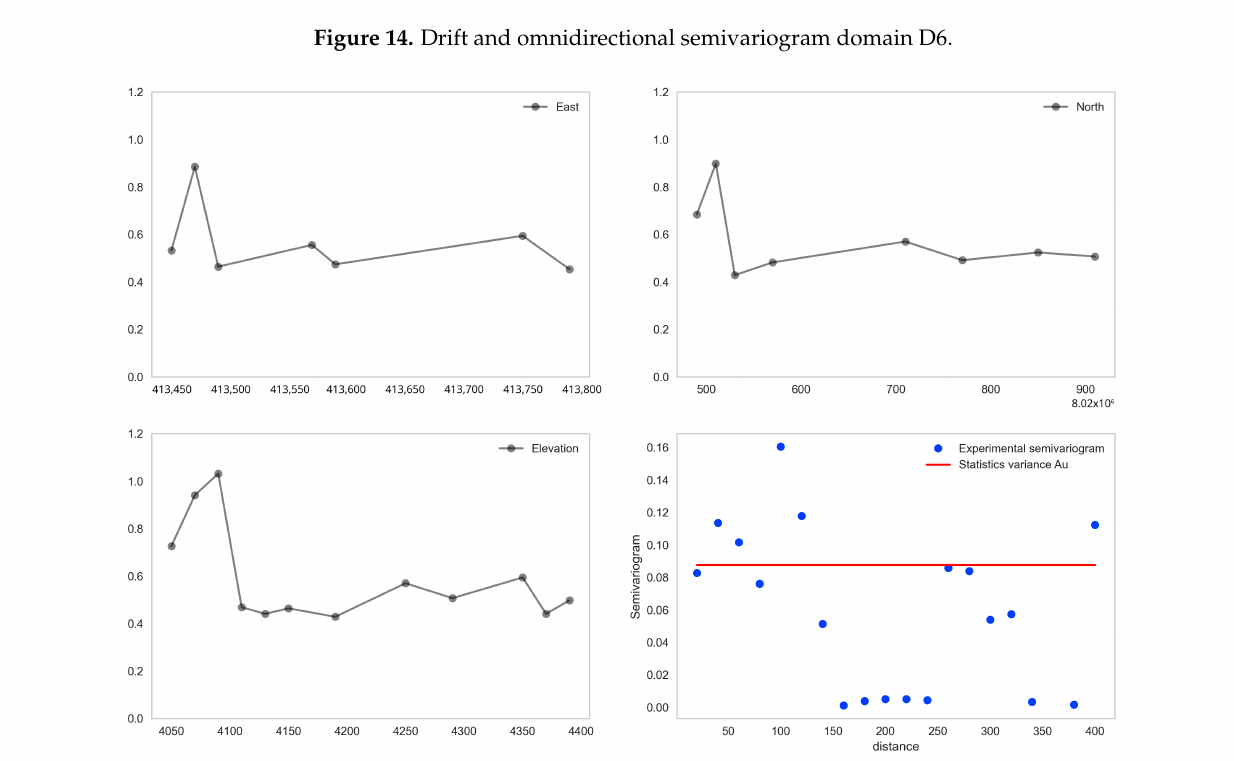
Figure 15. Drift and omnidirectional semivariogram domain